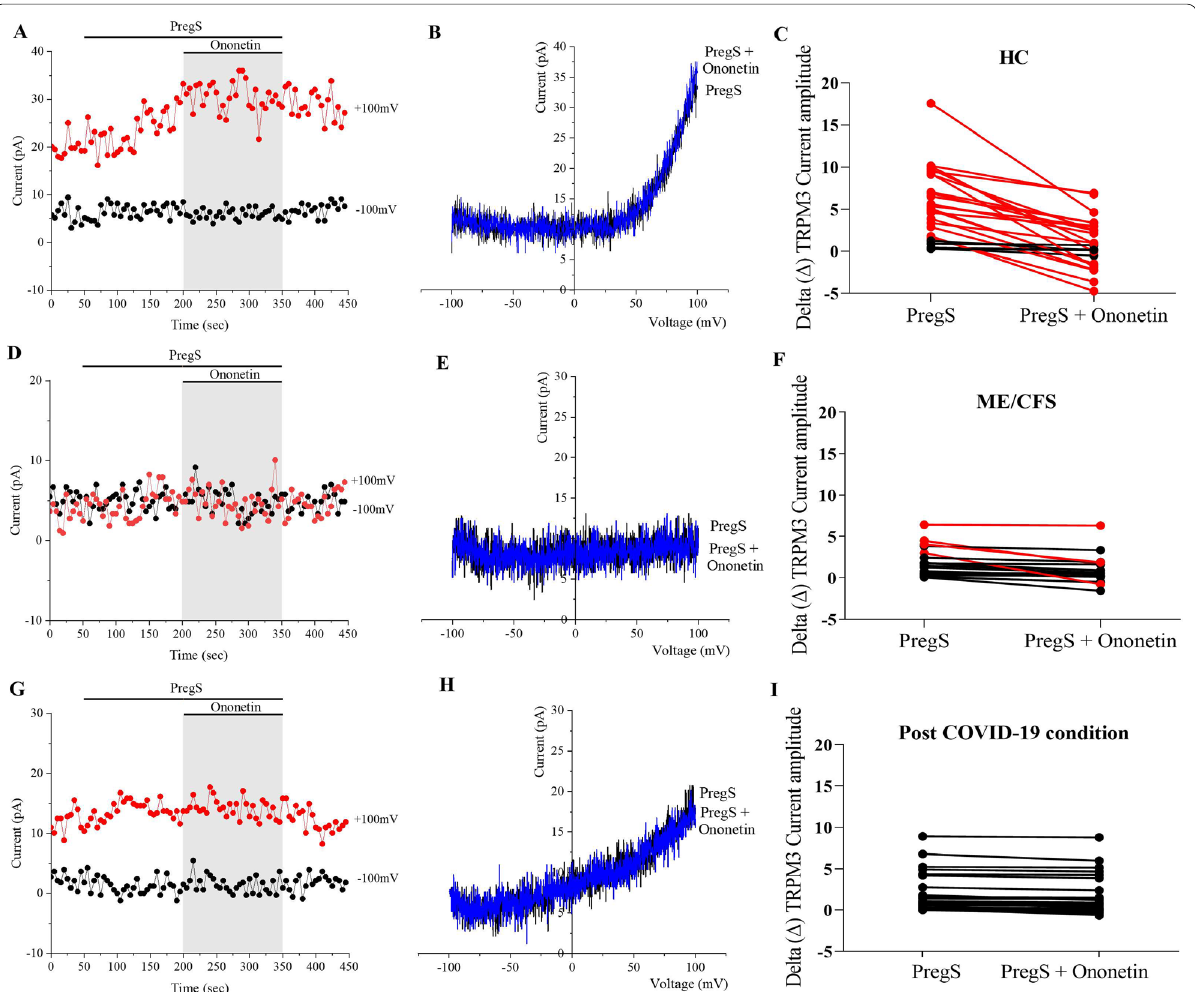
Fig. 2 TRPM3 activity after ononetin modulation. Data were obtained under whole‑cell patch‑clamp conditions. A A representative time‑series of current amplitude at 100 mV and 100 mV showing the effect of 10 μ Μ ononetin on ionic currents in the presence of PregS in isolated + − NK cells from HC. B I–V before and after application of ononetin in a cell as shown in ( A ). C Scatter plots representing change of each current amplitude before and after application of ononetin in presence of PregS in all NK cells from HC. D A representative time‑series of current amplitude at 100 mV and 100 mV showing the effect of 10 μ Μ ononetin on ionic currents in the presence of PregS in isolated NK cells ME/CFS patients. + − E I–V before and after application of ononetin in a cell as shown in ( D ). F Scatter plots representing change of each current amplitude before and after application of ononetin in presence of PregS in all NK cells from ME/CFS. G A representative time‑series of current amplitude at 100 mV + and 100 mV showing the effect of 10 μ Μ ononetin on ionic currents in the presence of PregS in isolated NK cells from post COVID‑19 condition. H − I–V before and after application of ononetin in a cell as shown in ( G ). I Scatter plots representing change of each current amplitude before and after application of ononetin in presence of PregS in all NK cells from post COVID‑19 condition. Each cell represented as red lines indicate cells sensitive to ononetin as a reduction in amplitude was recorded. HC (N 5; n 29), post COVID‑19 condition (N 5; n 27), and ME/CFS (N 5; n 23). N to = = = = = = number of participants and n to number of records analysed. HC healthy controls, ME/CFS myalgic encephalomyelitis/chronic fatigue